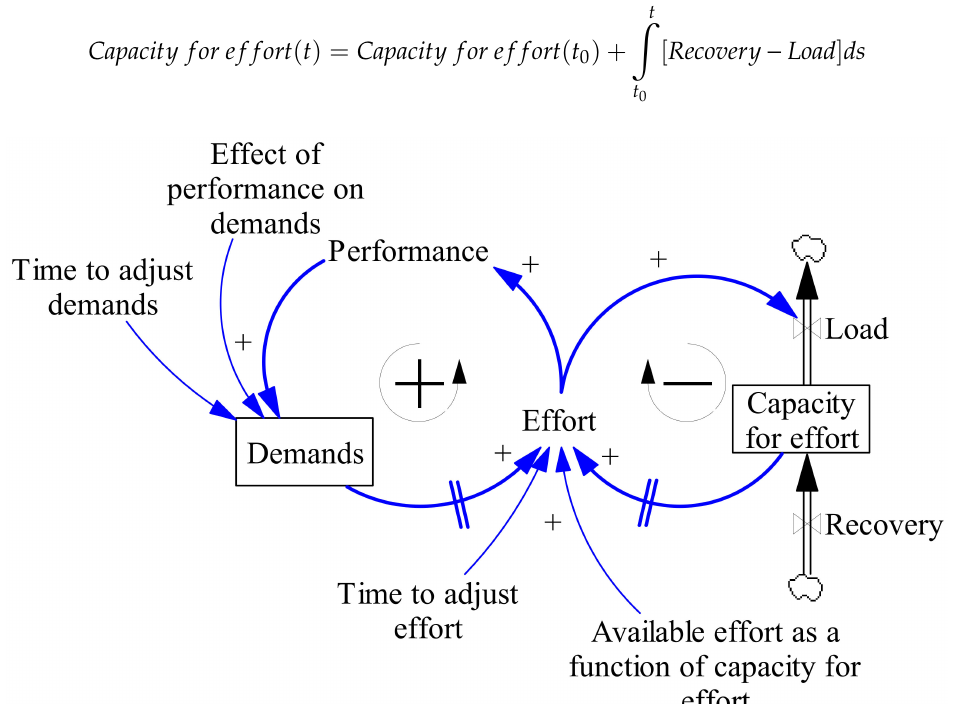
Figure 2. Example of a simplified system dynamics (SD) model of burnout to illustrate several key elements of a SD model. Stocks accumulate over time and are indicated by rectangles. Flows indicate the rate of change of a stock and are depicted as black arrows. Variables are connected with blue arrows indicating causal links, where a plus indicates that an increase (decrease) in the variable at the tail of the arrow constitutes an increase (decrease) in the variable at the head of the arrow, all things else being equal; whereas a minus indicates that an increase (decrease) in the variable at the tail constitutes a decrease (increase) in the variable at the head, all things else being equal. Delays ( // ) indicate that the increase occurs after or over multiple time periods. Feedback loops are indicated as black circular arrows. A feedback loop can be reinforcing ( + ) or balancing ( −